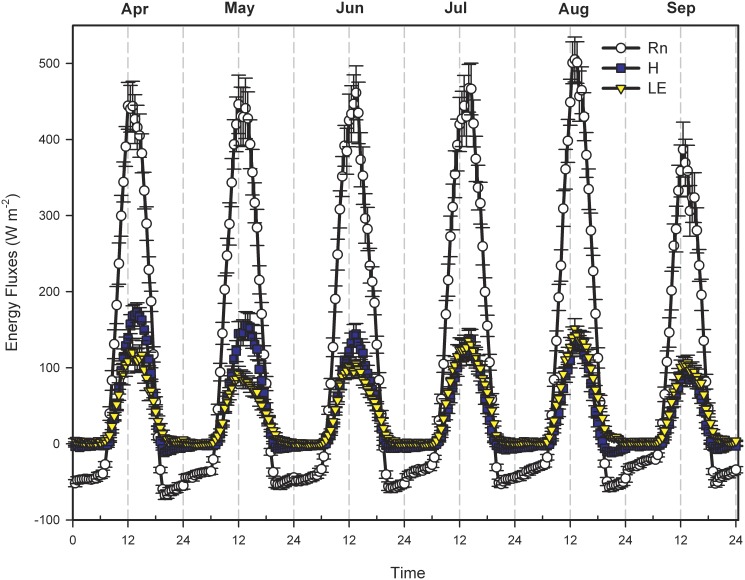
Monthly averaged diurnal variations of energy fluxes over the semi-arid farmland ecosystem in the Loess Plateau.Error bars represent one standard error. Rn, net radiation (W m−2); H, sensible heat flux (W m−2); LE, latent heat flux (W m−2).